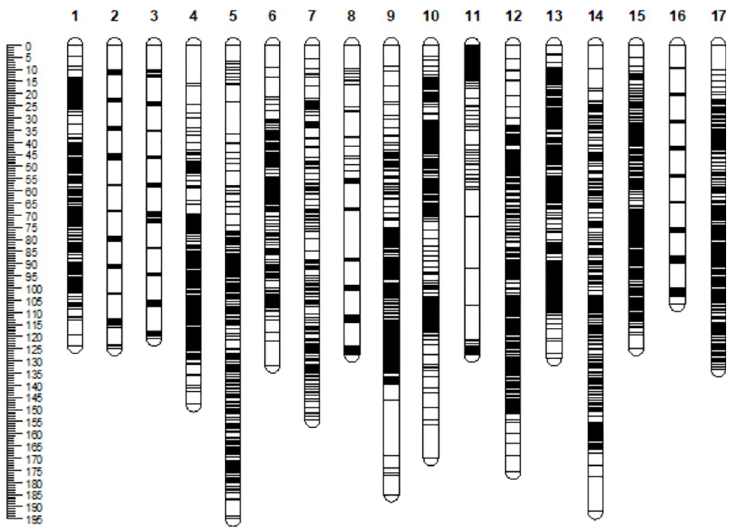
Fig 5. Marker distribution and genetic length of integrated map. Centimorgans (cM) indicated the genetic length of vertical scale. Black lines represent mapped markers. LG1–17 represents corresponding linkage